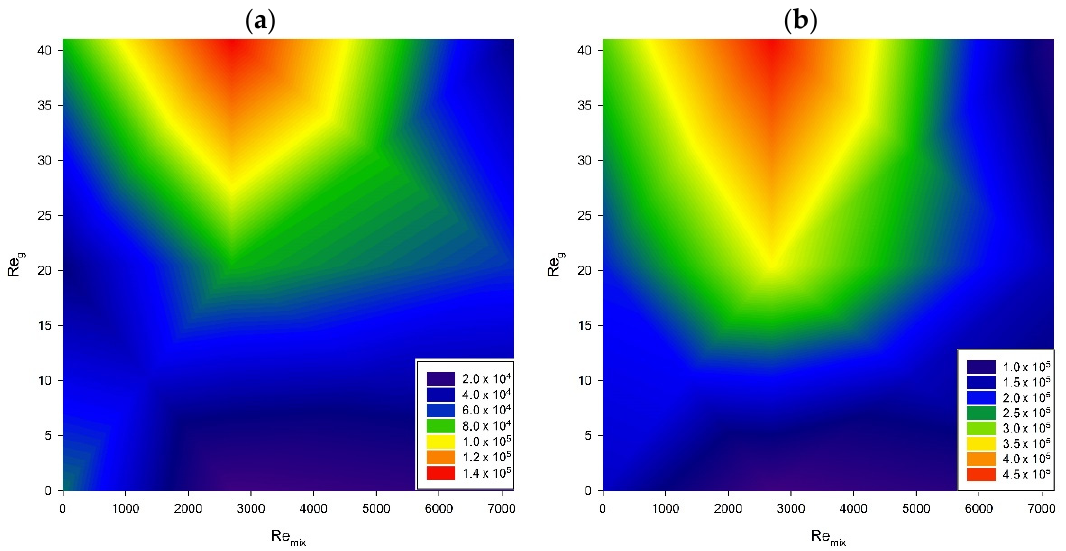
Figure 6. Impact of mixing with aeration on cell viability: ( a ) after 6 h, ( b ) after 12 h of process.